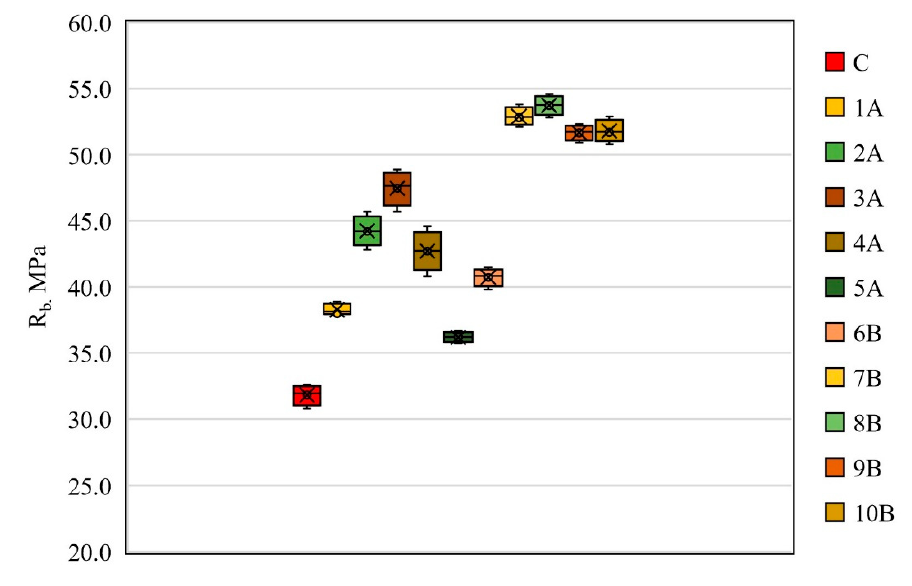
Figure 9. Strength of sample cubes after heat treatment (drying).